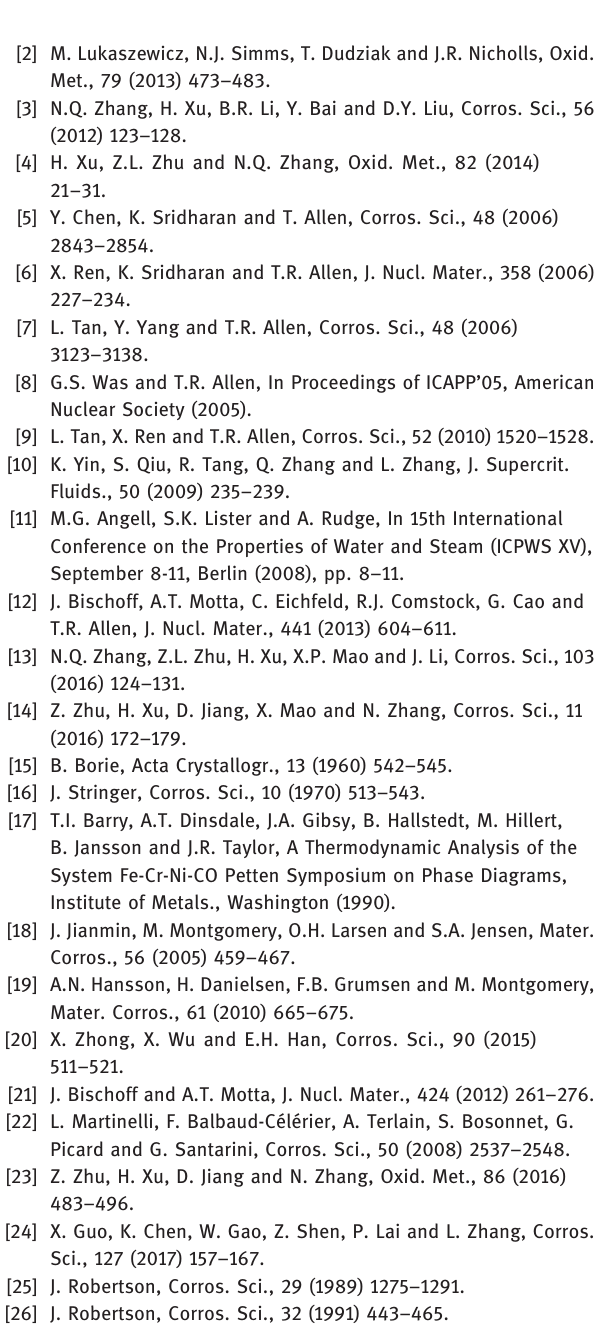
Table 2: Summary of the thickness of oxide, the thickness ratio of the outer layer to the inner layer and weight gain at different oxidation time. Temperature (°C)    Oxidation time (h)        Outer layer  .   .   .   .   .   .   .  Oxide thickness ( μ m) Average inner layer  .   .   .   .   .  Total thickness  .   .   .   .   .   .   .  Average outer/inner thickness  .  Calculated total O absorbed (mg/cm  ) Measured weight gain (mg/cm 